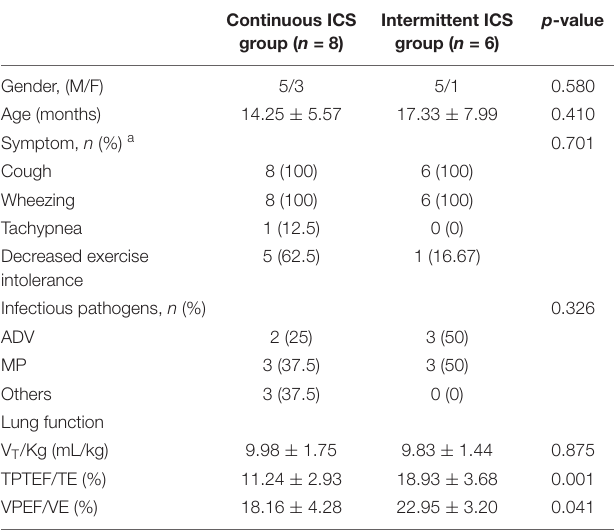
TABLE 2 | Comparison of clinical data between Continuous ICS group and intermittent ICS group at baseline (age ≤ 5 years old).